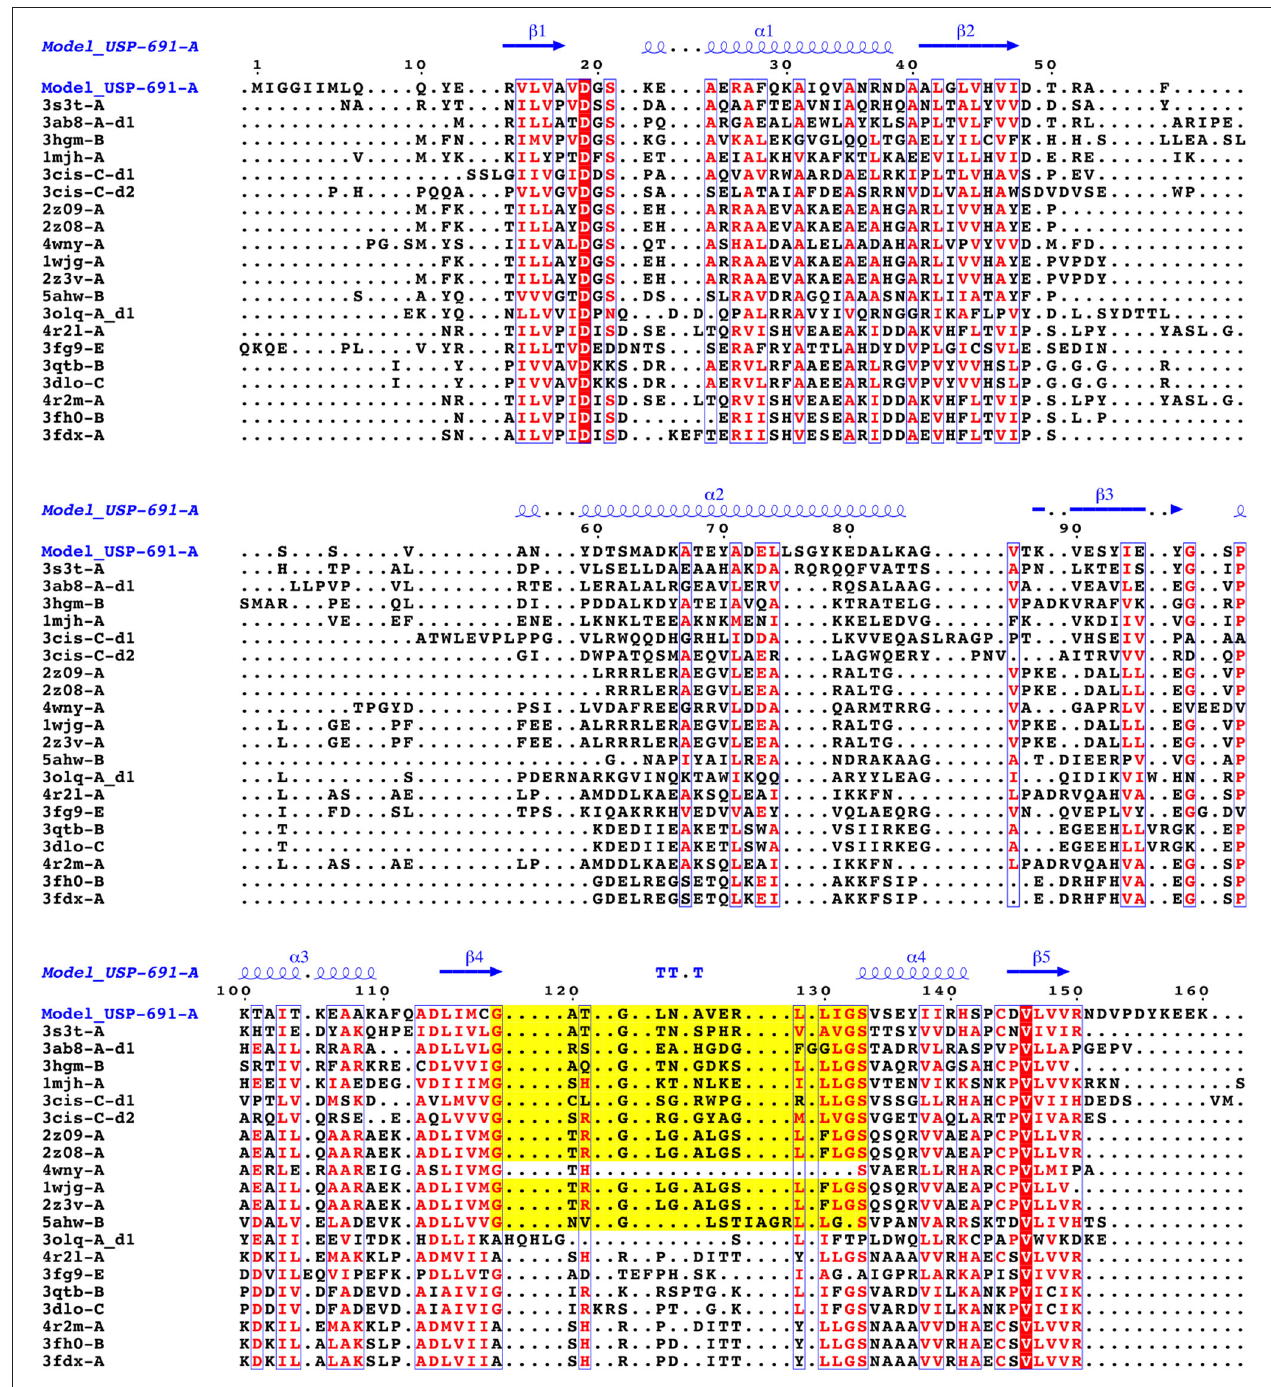
FIGURE 9 | Multiple structural alignment of sequences between the chain A of Model_USP-691 and proteins of homolog structures. The number of domains are reported as d1or d2. The residues that are conserved in at least 60% of all sequences are highlighted in red. The conserved residues are represented in blue boxes. ATP-binding motif is in